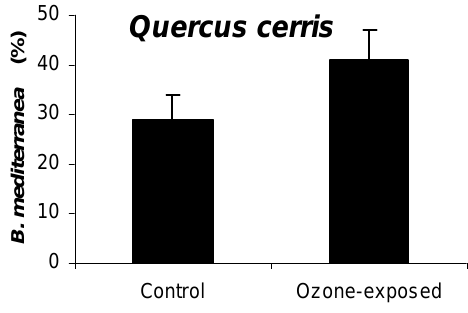
FIGURE 2. Percent of fungal isolates from foliage of Q. cerris seedlings that were B. mediterranea isolates (+SD) in control (charcoal-filtered) and O 3 -exposed (110 ppb O 3 , 5 h day –1 , 30 days) seedlings after a 1-month exposure in a Q. cerris forest naturally infected by B. mediterranea . n =